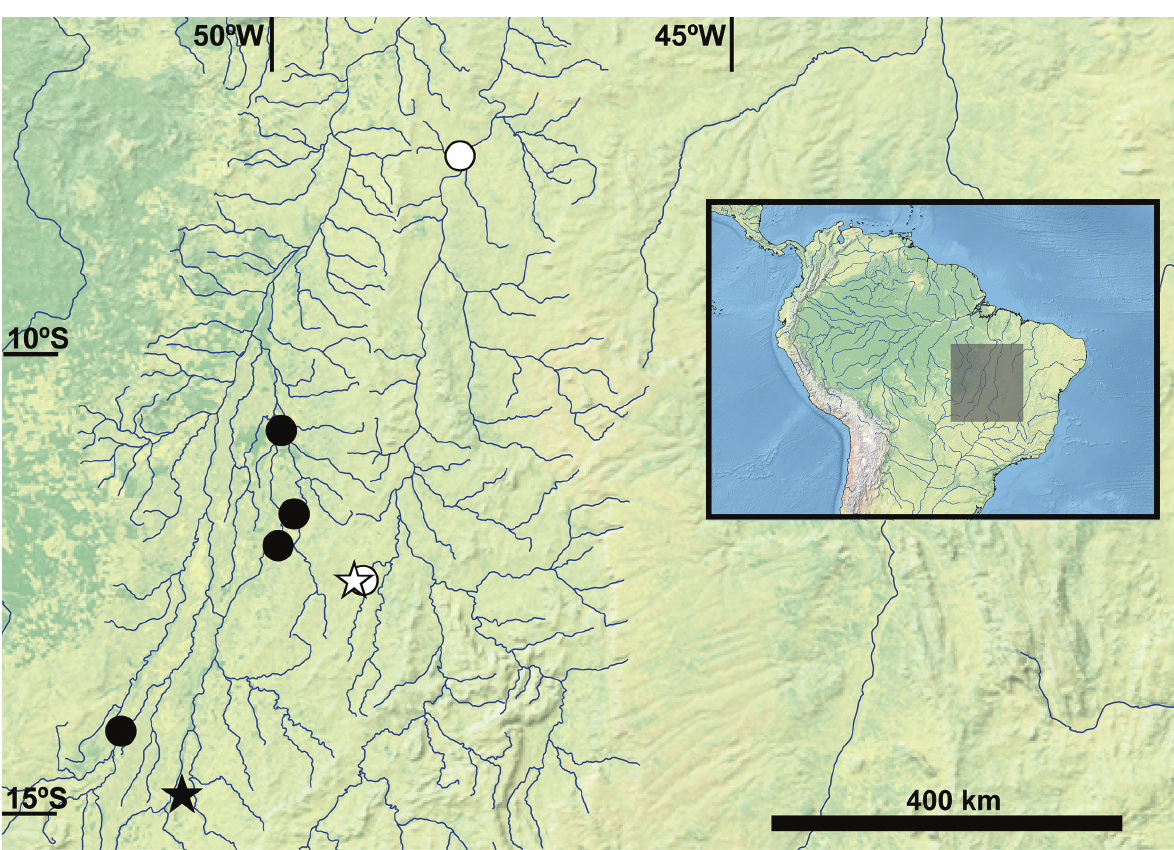
Figure 6. Geographical distribution of Spectrolebias costae (black symbols) and S. gracilis sp. n. (white symbols). Stars indicate type